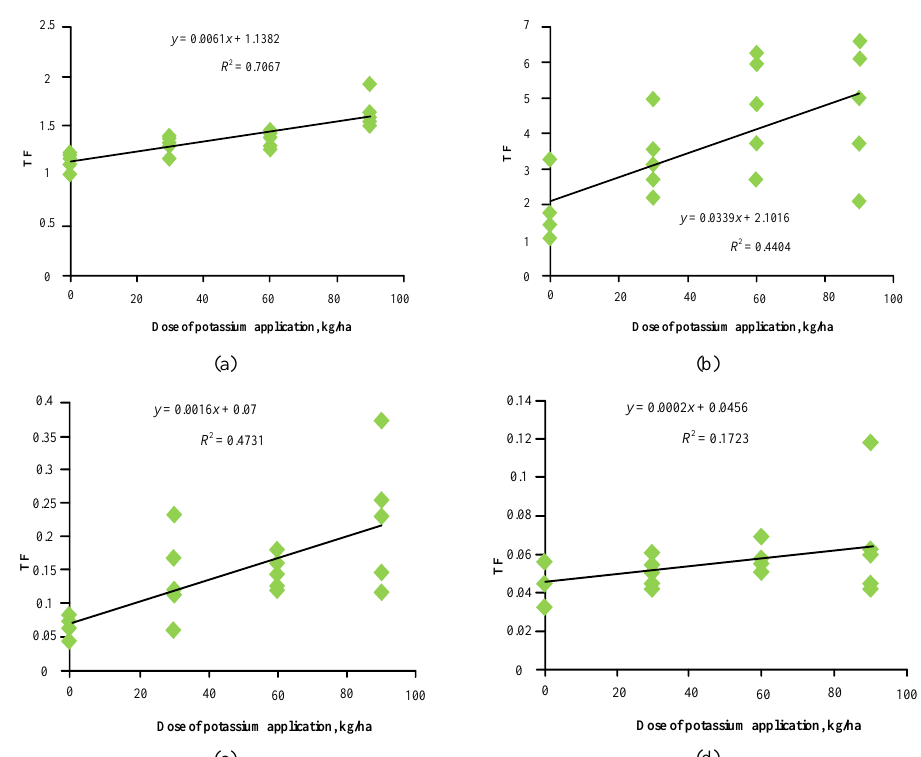
Fig. 2. The diagram of dose-response relationship of: (a) Cu; (b) Zn; (c) Mn; (d) Pb accumulation (TF) and potassium application rate for willow leaves.